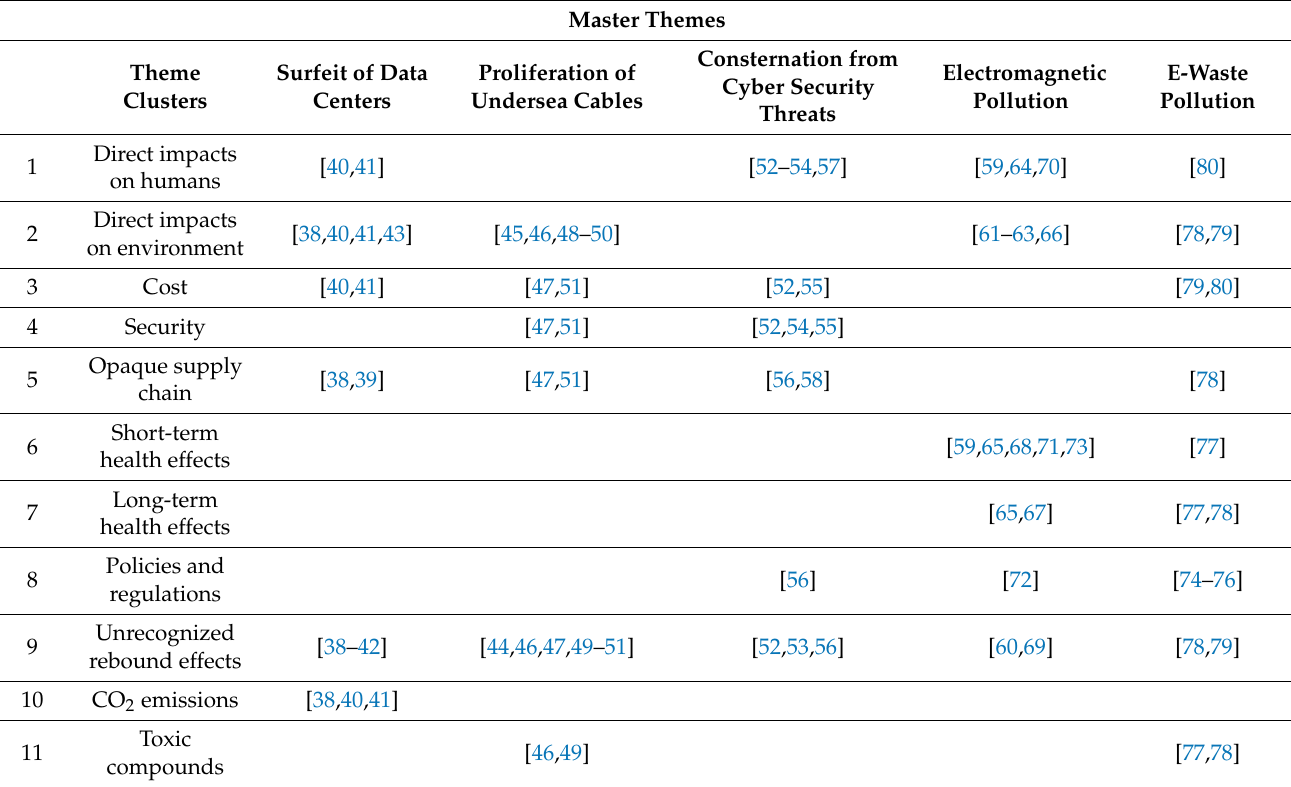
Table 2. Summary table of results generating master